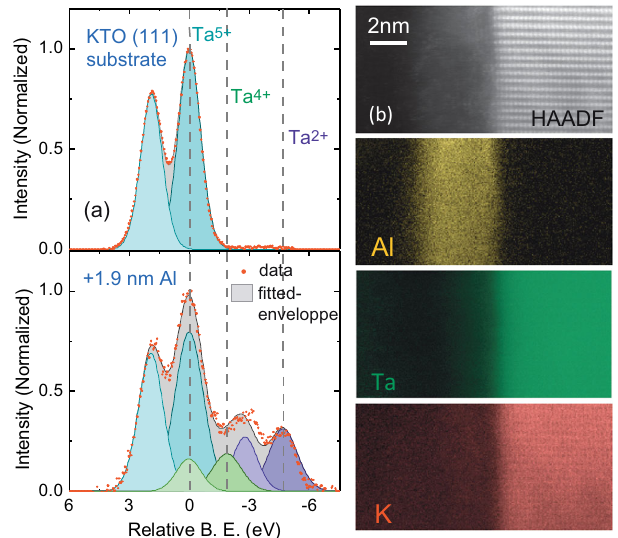
Fig. 1 | XPS and STEM characterization of the AlOx/KTaO 3 samples. a X-ray photoelectron spectra near the 4f core level binding energy of Ta for a KTaO 3 - substrate prior to deposition (top) and after deposition of 1.8nm of Al (bottom). The fi tted peaks for Ta 5+ , Ta 4+ , and Ta 2+ are shown in cyan, green and violet colors, respectively. The deeper and lighter shades of the same colors represent the 4f 5/2 and 4f 2/2 valence states of the respective peaks. The data and sum fi t envelope are showninredcirclesandblacklines. b (top)HAADFscanningtransmissionelectron microscopyimageatthecross-sectionofKTaO 3 (111)andAlO x interface.TheKTaO 3 is observed along the [112] direction. (down) EELS maps (Al-L 2,3 , Ta-O 2,3 , and K-L 2,3 edges)showingthepresenceofAlontopoftheinterfacewithoutanyinterdiffusion but with some limited diffusion of Ta and K inside the AlO x